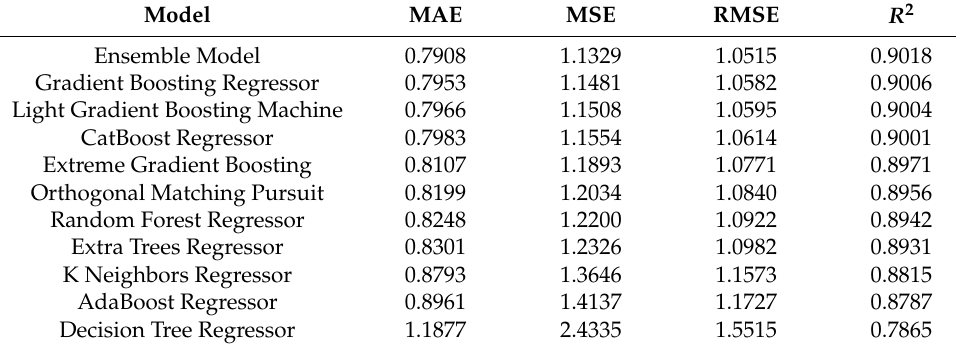
Figure 17. Accuracy of Ensemble Model for Minimum Temperature forecasting. Table 3. Model performance for Minimum Temperature Forecasting.